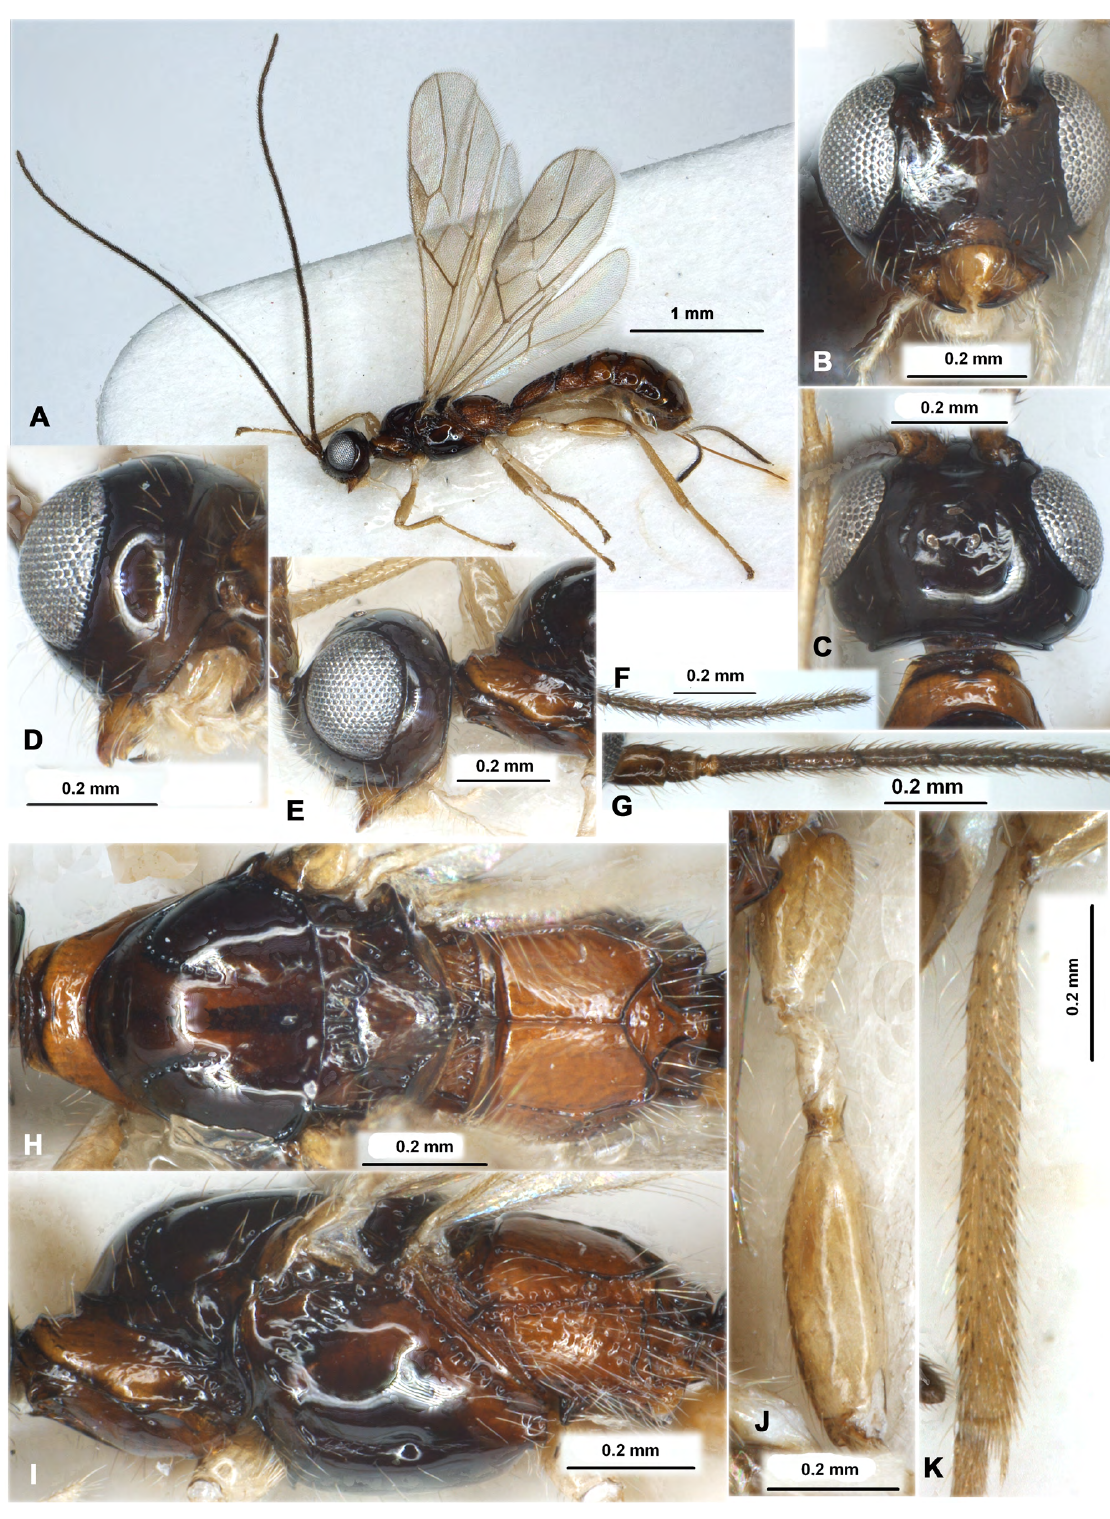
Fig. 18. Ipodoryctes ( Afroipodoryctes ) reunionus sp. nov., ♀, holotype, MNHM. A . Habitus, lateral view. B . Head, front view. C . Head, dorsal view. D . Head, latero-posterior view. E . Head, lateral view. F . Apical segments of antenna. G . Basal segments of antenna. H . Mesosoma, dorsal view. I . Mesosoma, dorsal view. J . Hind coxa and femur. K . Hind